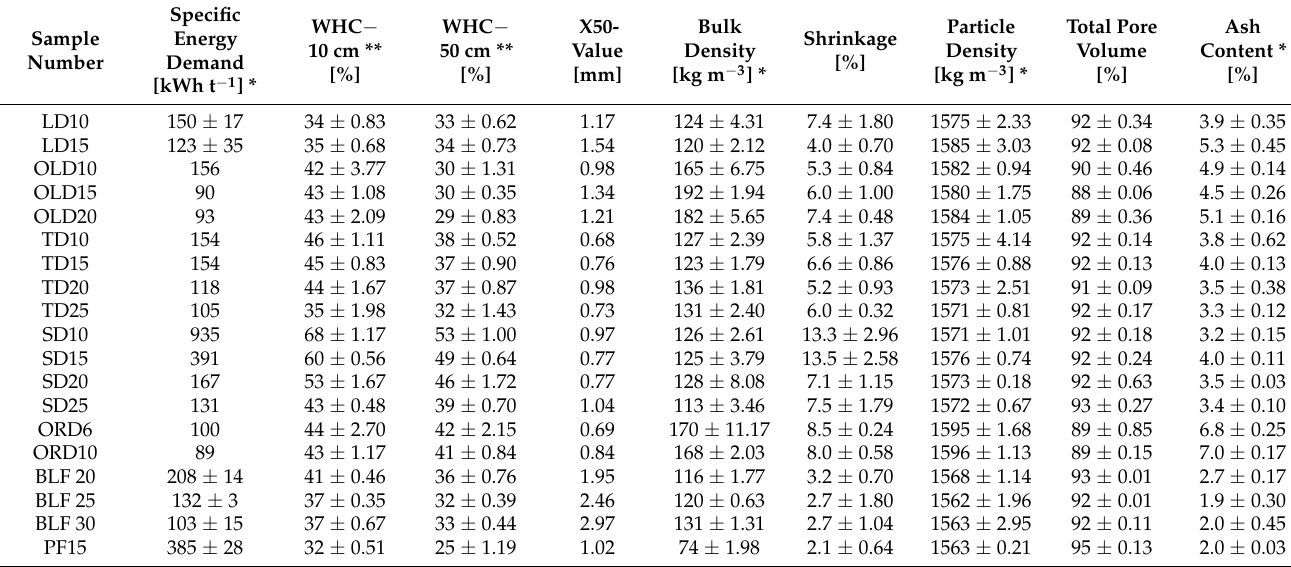
Table A1. Specific energy demand, WHC, X50-value bulk density, shrinkage, particle density, total pore volume and ash content for all extruded material at all aperture settings with standard